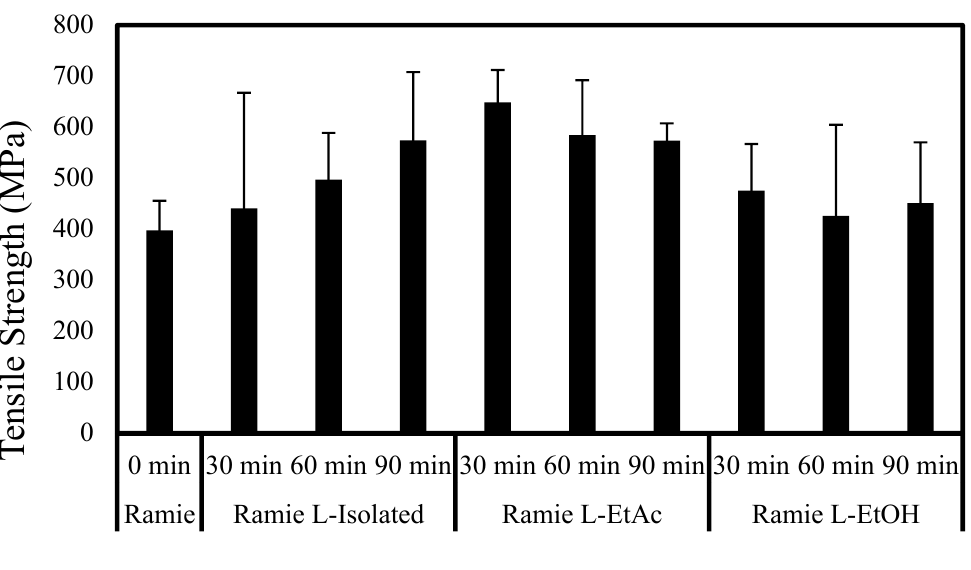
Figure 10. Variation of tensile strength of modified ramie fiber.